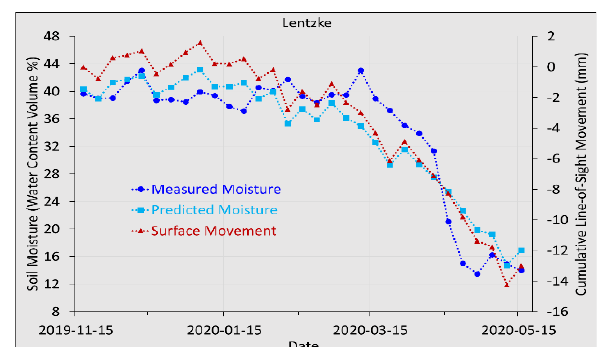
Figure 7. Comparison of soil moisture and SBAS-derived movement at Lentzke (Figure 3). Movement: negative and positive, away and towards Sentinel-1 antenna. Sample dates correspond to Sentinel-1 acquisitions.